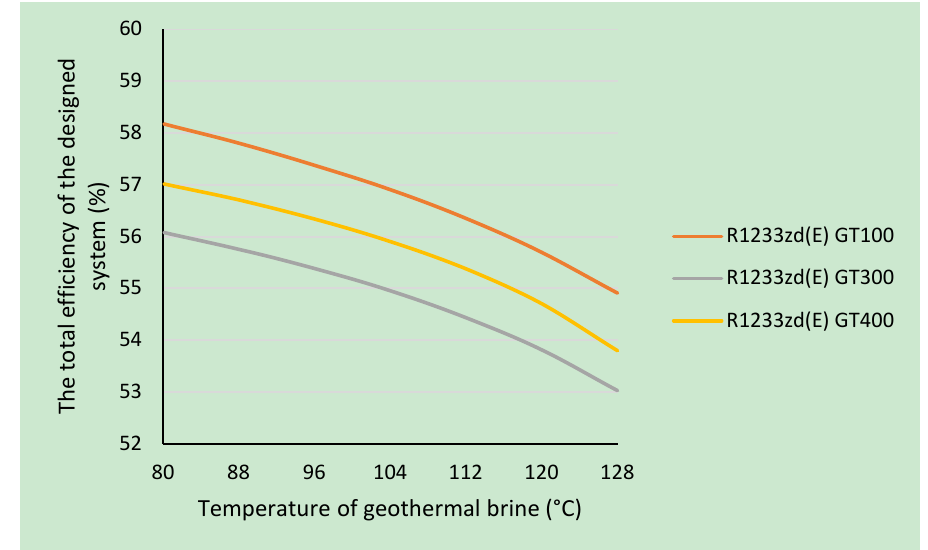
Figure 13. The total efficiency of modified ORC installation assisted by gas turbine as a function of the geothermal brine temperature with R1233zd(E) as a working fluid for different gas turbine types.